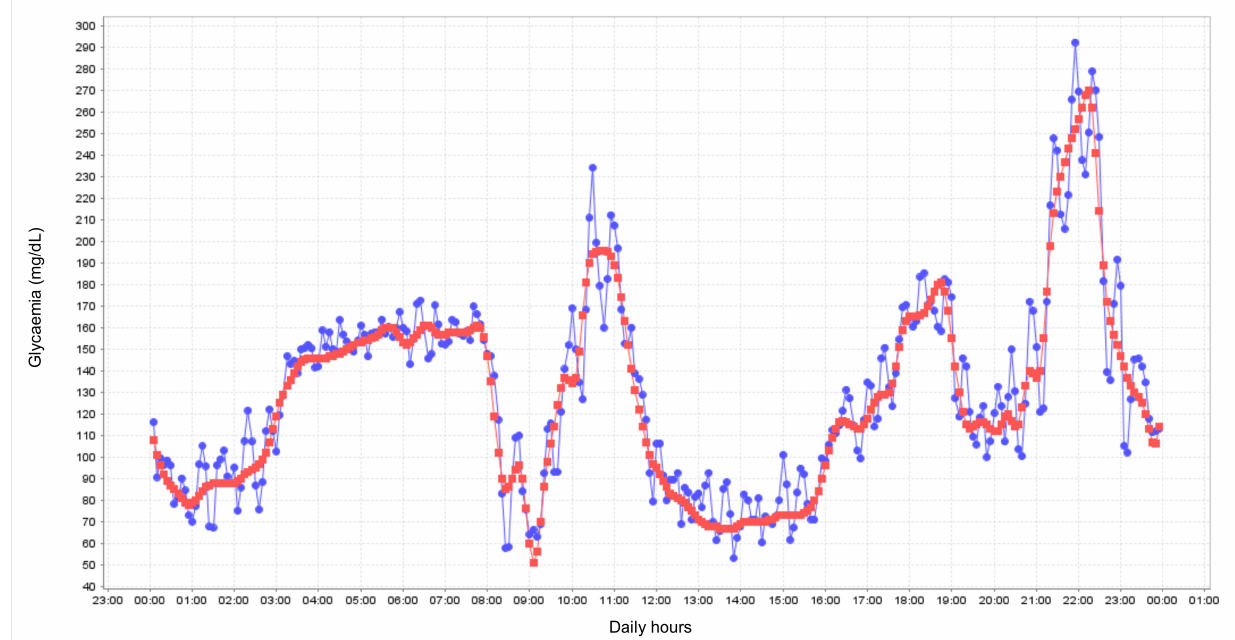
Figure 3. Example of forecasting stage with RF algorithm of the subset RF from patient ‘01’ for a 60 min PH glycemia prediction. Red, real data of glycaemia; Blue, predicted